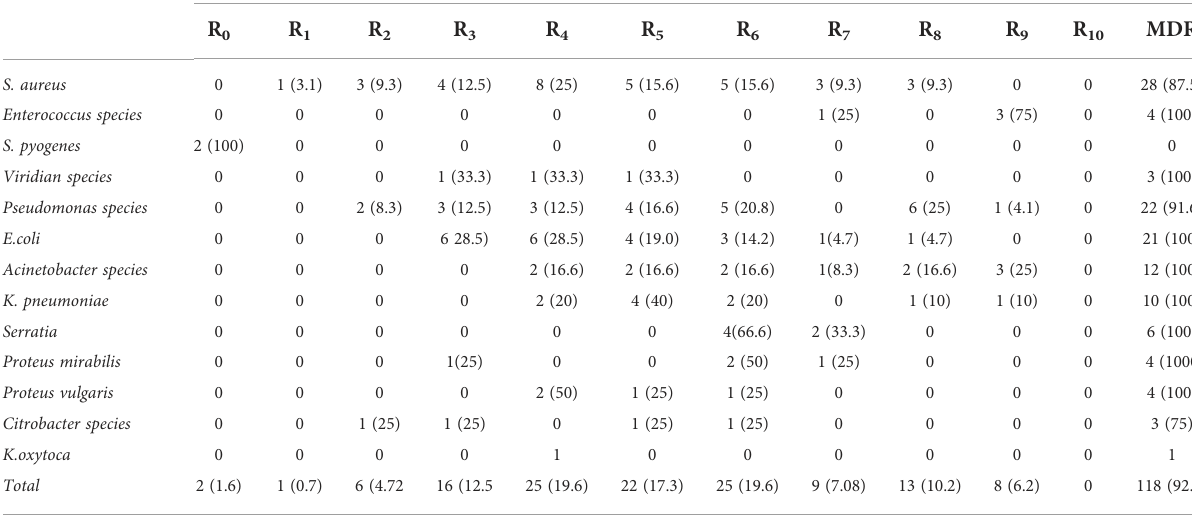
Antibiogram pattern, N (%)